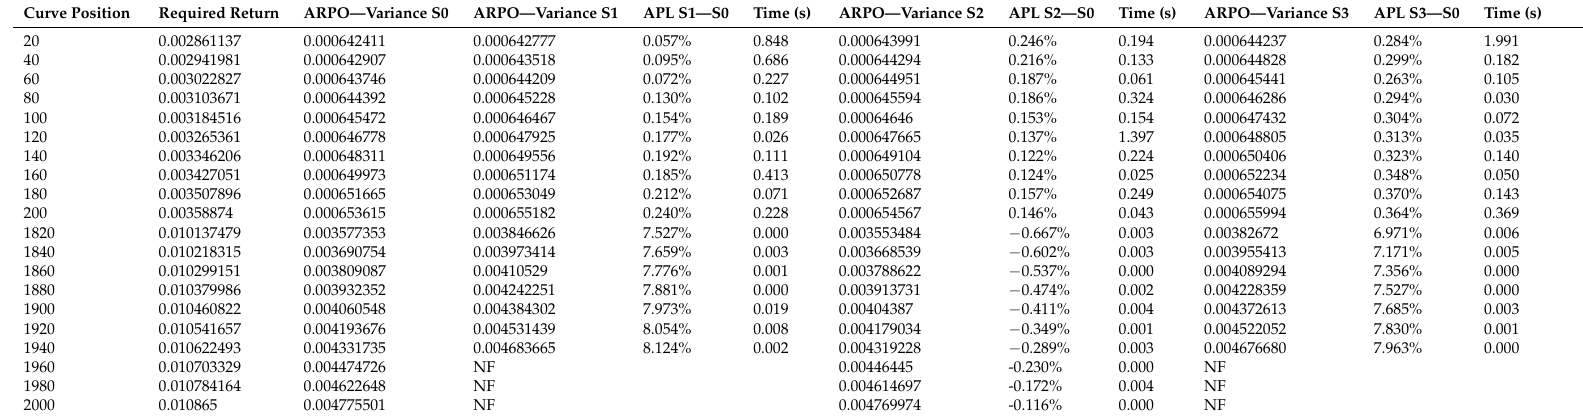
Table 7. Comparison of results for different scenarios based on Instance 1 (Hang Seng) varying the returns and the covariance matrix. Curve Position